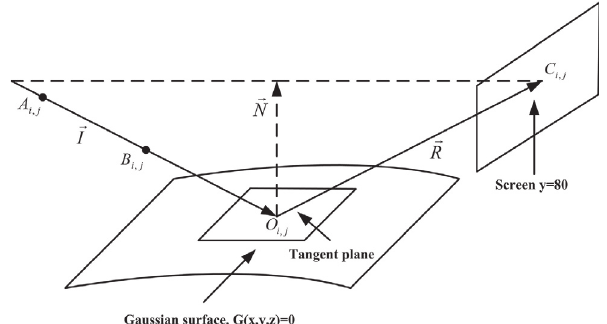
Figure 6: Illustration for reflection model.